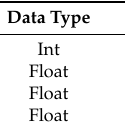
Table 2. Reliability Feature Extraction.